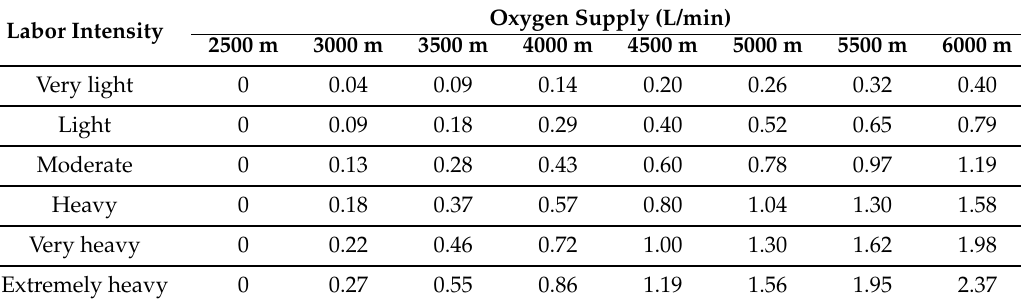
Table 10. Oxygen-supply standard based on labor ability of construction personnel. Labor Intensity